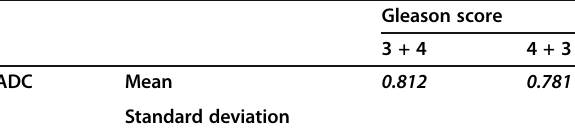
Table 6 Demonstrating the difference between the mean ADC value and the standard deviation of Gleason score 3 + 4 and